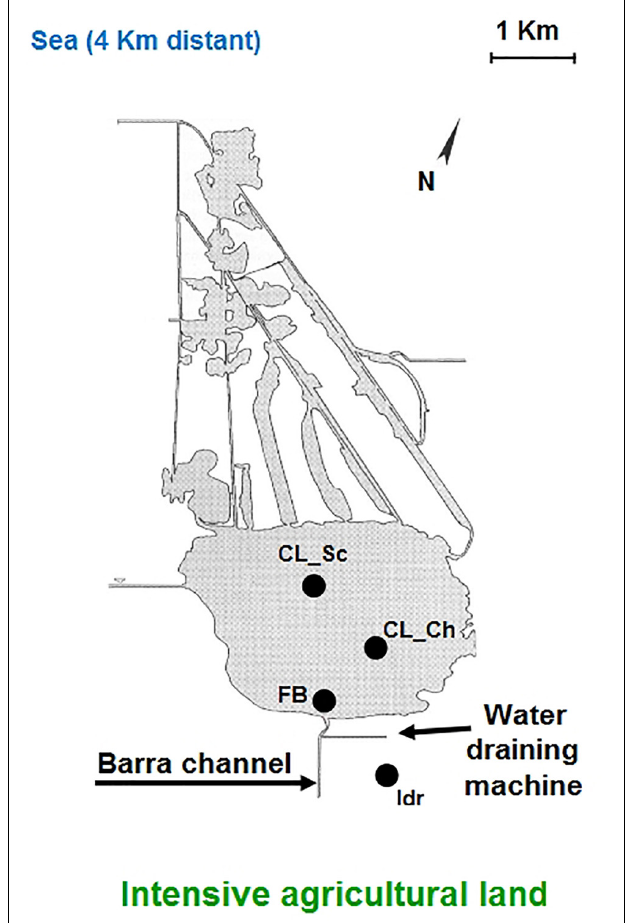
FIGURE 1 | Schematic representation of the Massaciuccoli basin structure and geographic position; the four sampling sites are indicated in the